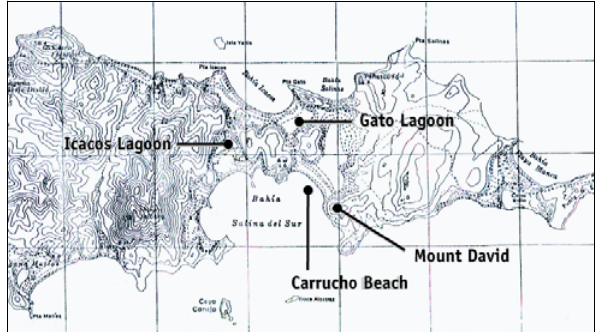
Figure 1: Sampling locations at the former Atlantic Fleet Weapons Training Facility (Vieques, PR).